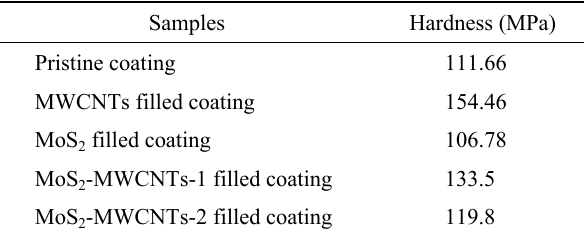
Table 2 The effect of filler kinds on the hardness of polyurethane composite